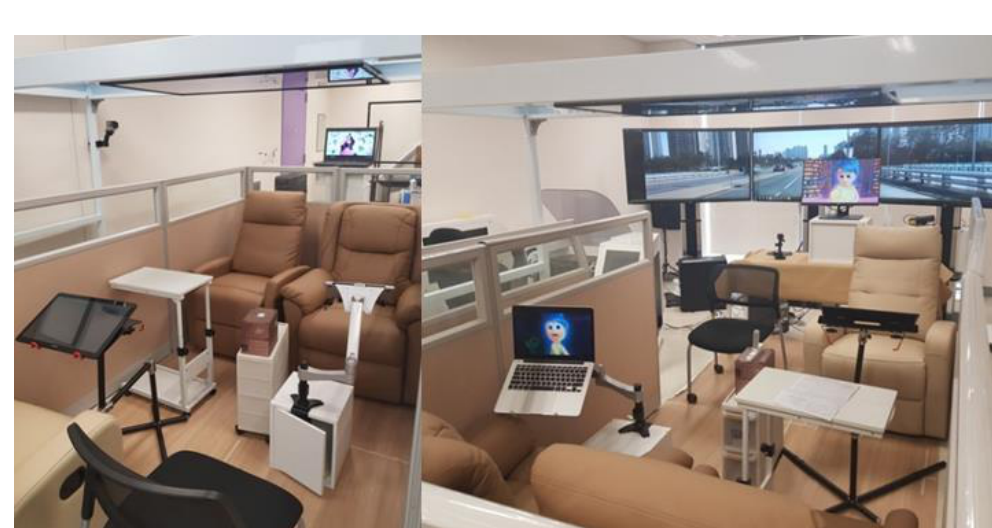
Figure 1. Layout of experiment environment of a fully autonomous vehicle.